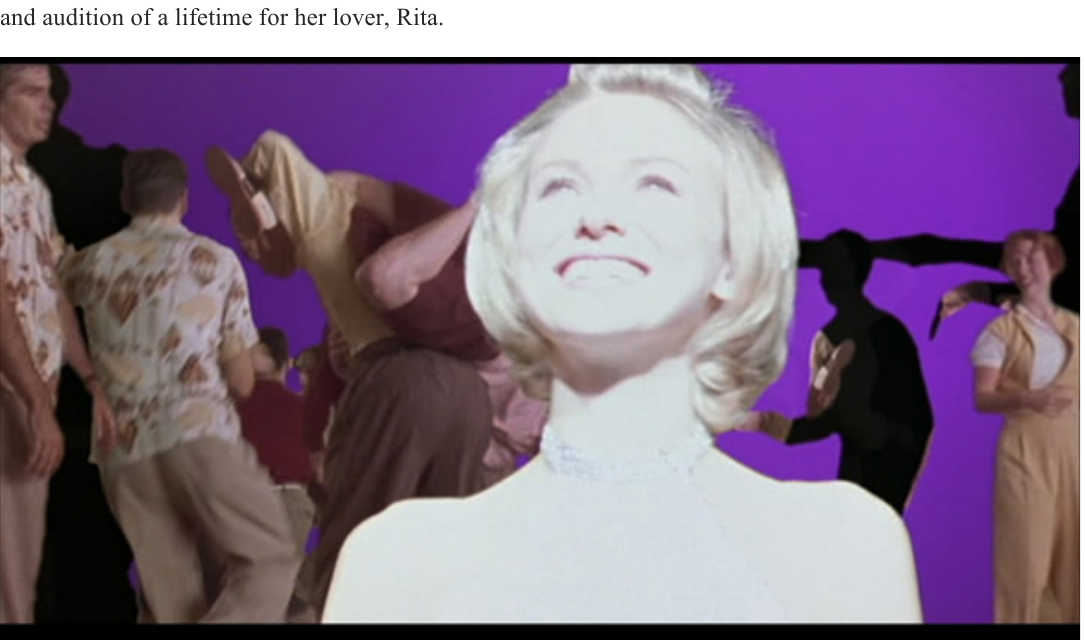
Figure 4: Play of fantasies in the opening of Mulholland Drive